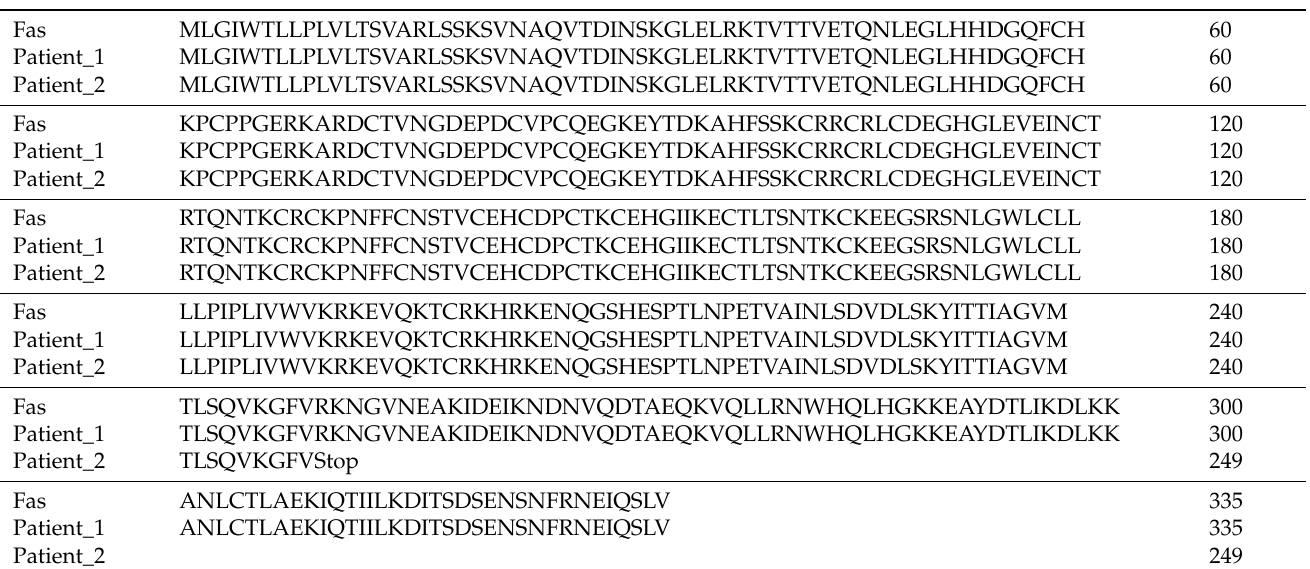
Figure 1. Molecular analysis of the sequence of Fas . mRNA was amplified by RT-PCR, and cDNA was sequenced directly. Electropherograms show a change of C to T identified in patient 2. As a control, we use the sample from a healthy 13-year-old girl. Table 2. Amino acid sequence alignment of the canonical sequence of Fas (UniProtKB, P25445) and sequences from the patients. Stop codon in the sequence of patient 2 is